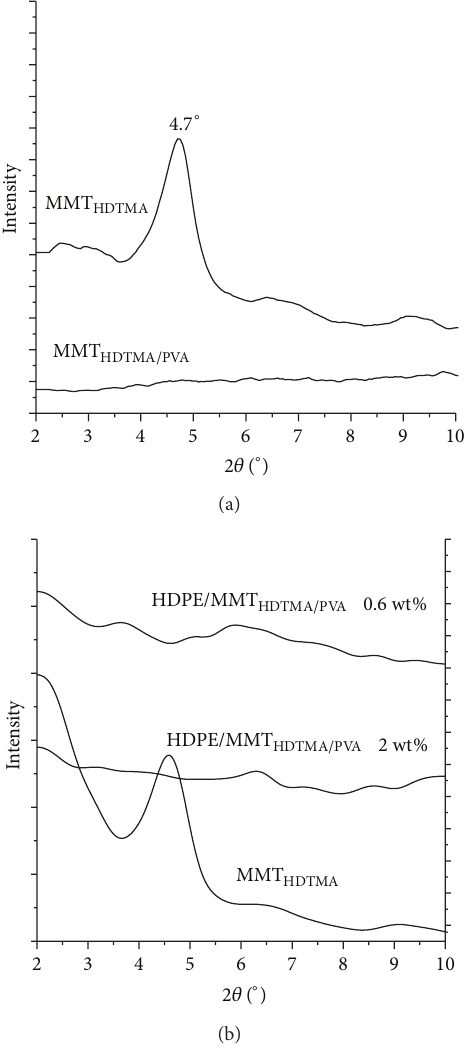
Figure 1: X-ray diffraction curves of (a) MMT and (b) MMT and HDPE/MMT MMT HDTMA/PVA HDTMA with 0.6 wt% and 2 wt%.